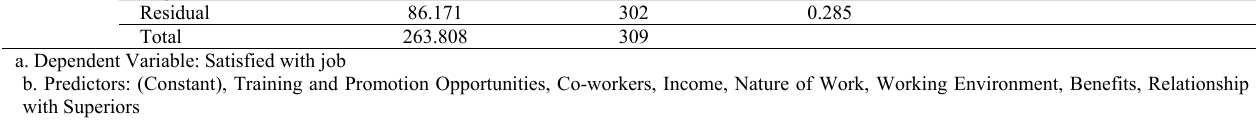
Suitability test (ANOVA) Model Sum of